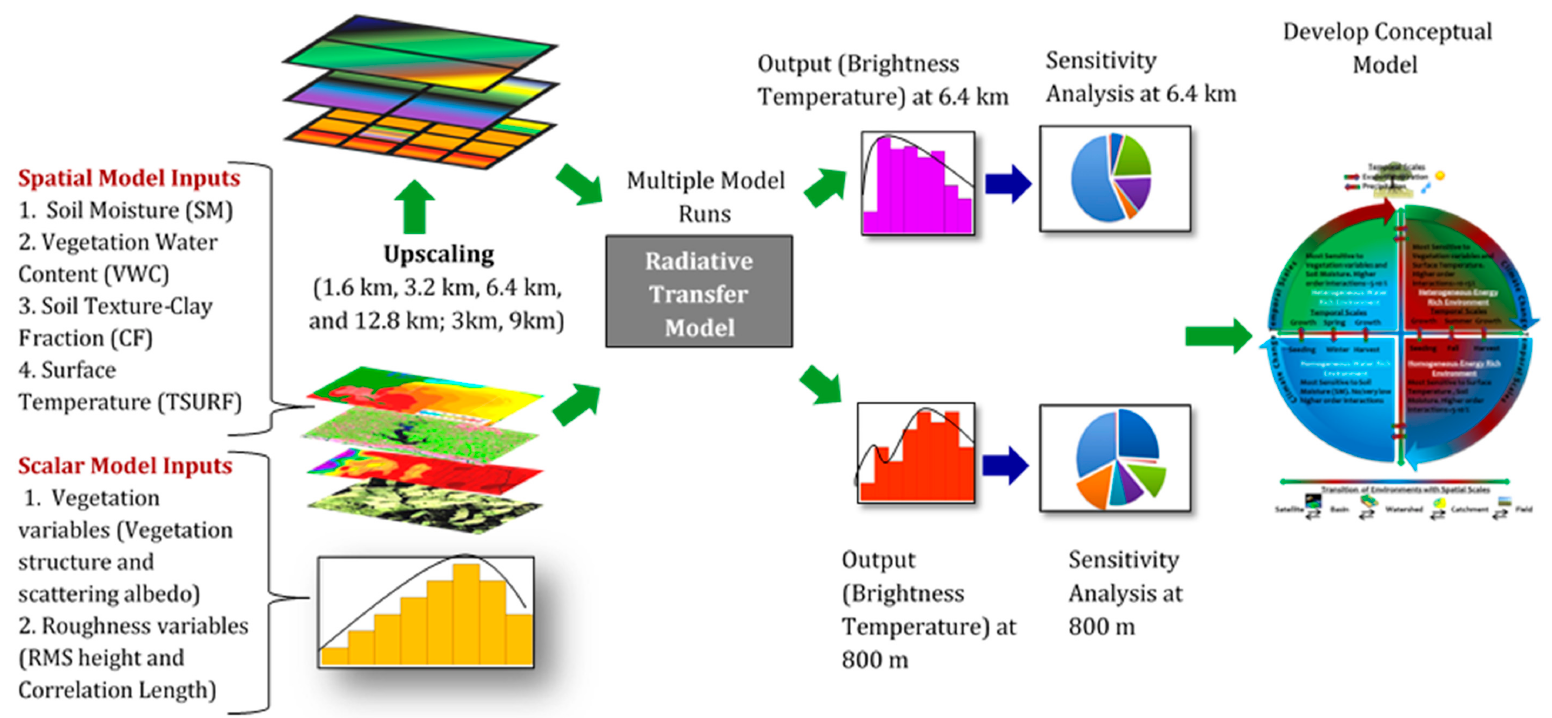
Figure 1. Methodology flowchart for implanting global spatial sensitivity analysis.